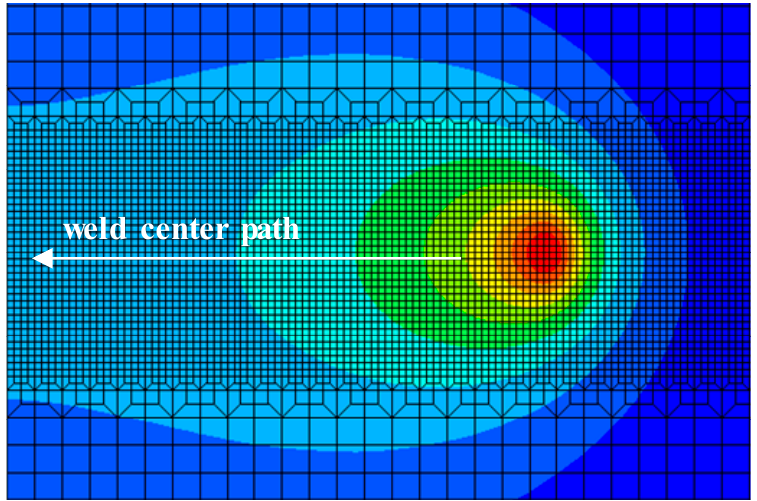
Figure 6. Node temperature sampling path.